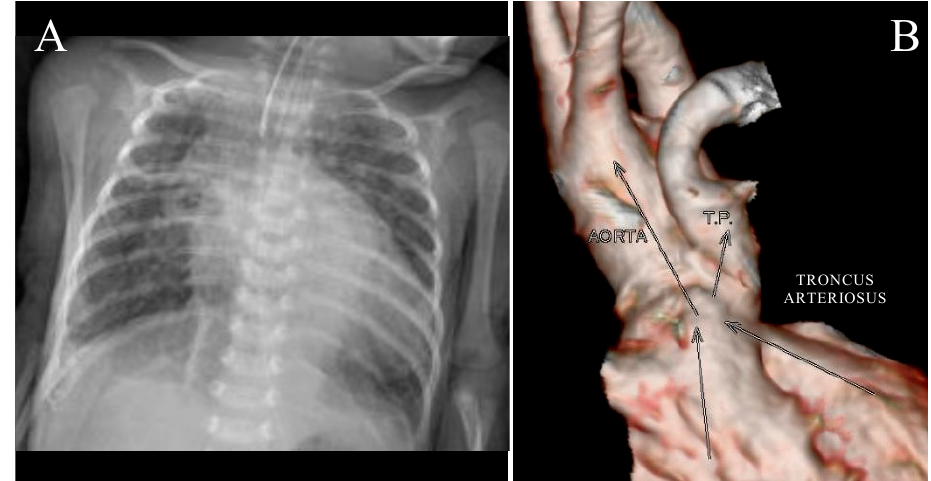
Figure 3. Patient positive for 22q11.2 microdeletion syndrome: ( A ) Chest roentgenography showing grade III cardiomegaly and right lung congestion; ( B ) angiotomography showing truncus arteriosus type I and pulmonary stenosis.